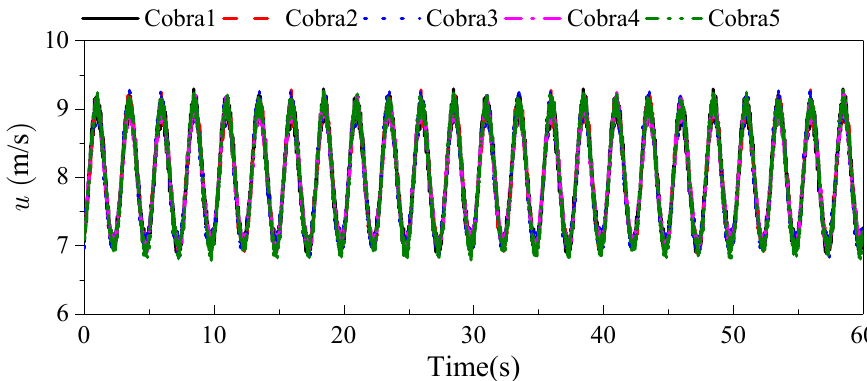
Figure 3. Time history of one of the sinusoidal flows.